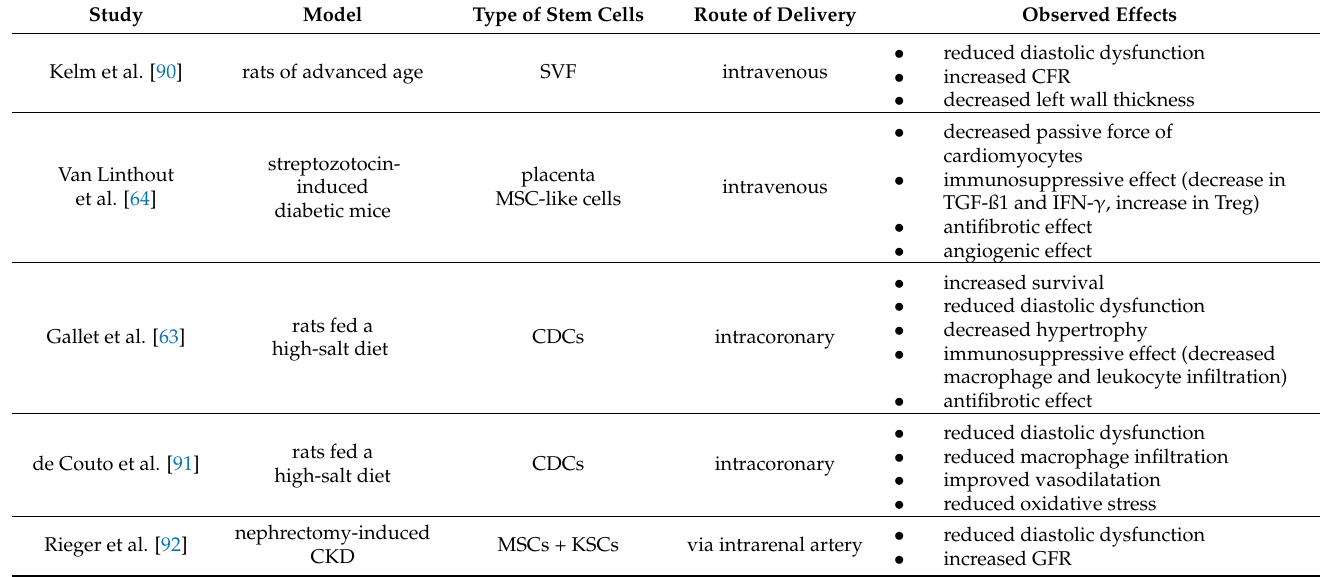
Table 1. Effects of stem cell therapy in controlled experimental